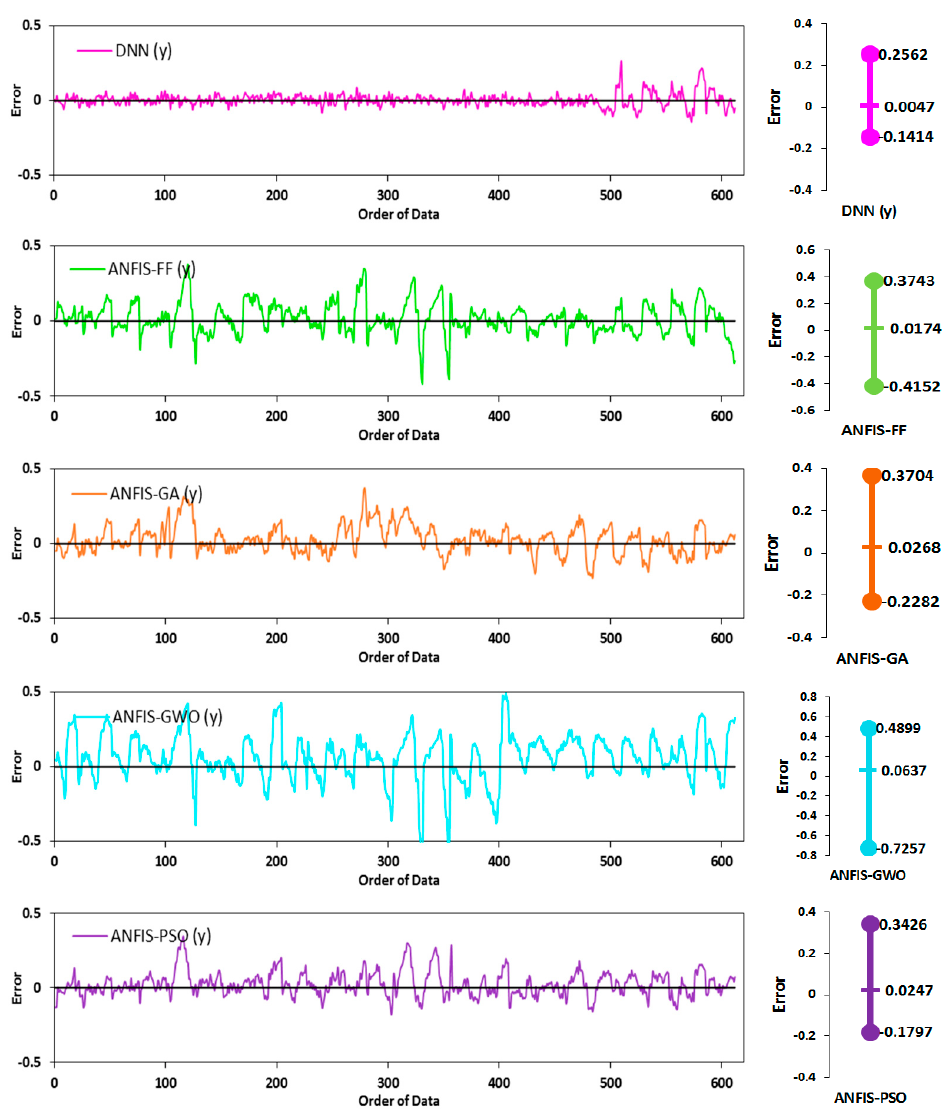
Figure 13. Error diagram in y direction.